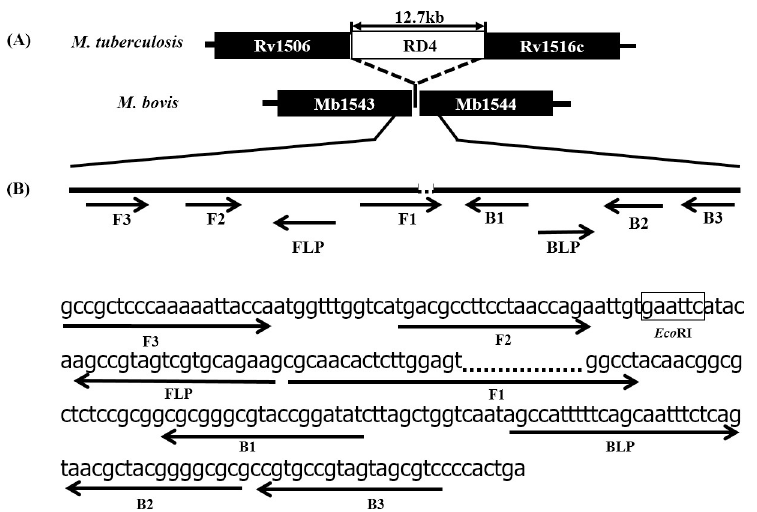
the LAMP assay sensitivity decreased; thus, the optimal temperature was determined as 66˚C. The effect of loop primers was tested at varying concentrations (Table 3). Upon adding 5.0 μ M of loop primers to the primer mixture, the assay’s detection speed improved with M . bovis; however, false positives from M . tuberculosis were observed. Reducing the concentration of loop primers (4.2 μ M) improved the specificity. We observed that by using the lowest concen- tration of loop primers (2.8 μ M) LAMP specificity improved, but sensitivity was reduced. Therefore, the optimal concentration of loop primers was determined as 3.6 μ M. Primer mix- ture volume was optimized in the same way and a 2.25 μ l/reaction volume was determined to be optimal. With this combination of conditions, no false positives with M . tuberculosis were observed up to 120 min incubation. Considering these adjustments, the final LAMP reaction conditions for our new assay were as follows: reaction temperature of 66˚C; 2.25 μ l of final primer mixture comprising of 0.6 μ M of each outer primer, 4.8 μ M of each inner primer,